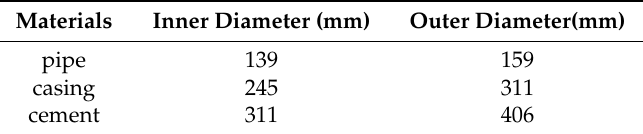
Table 4. The inner and outer diameter of the casing, pipe, and cement.